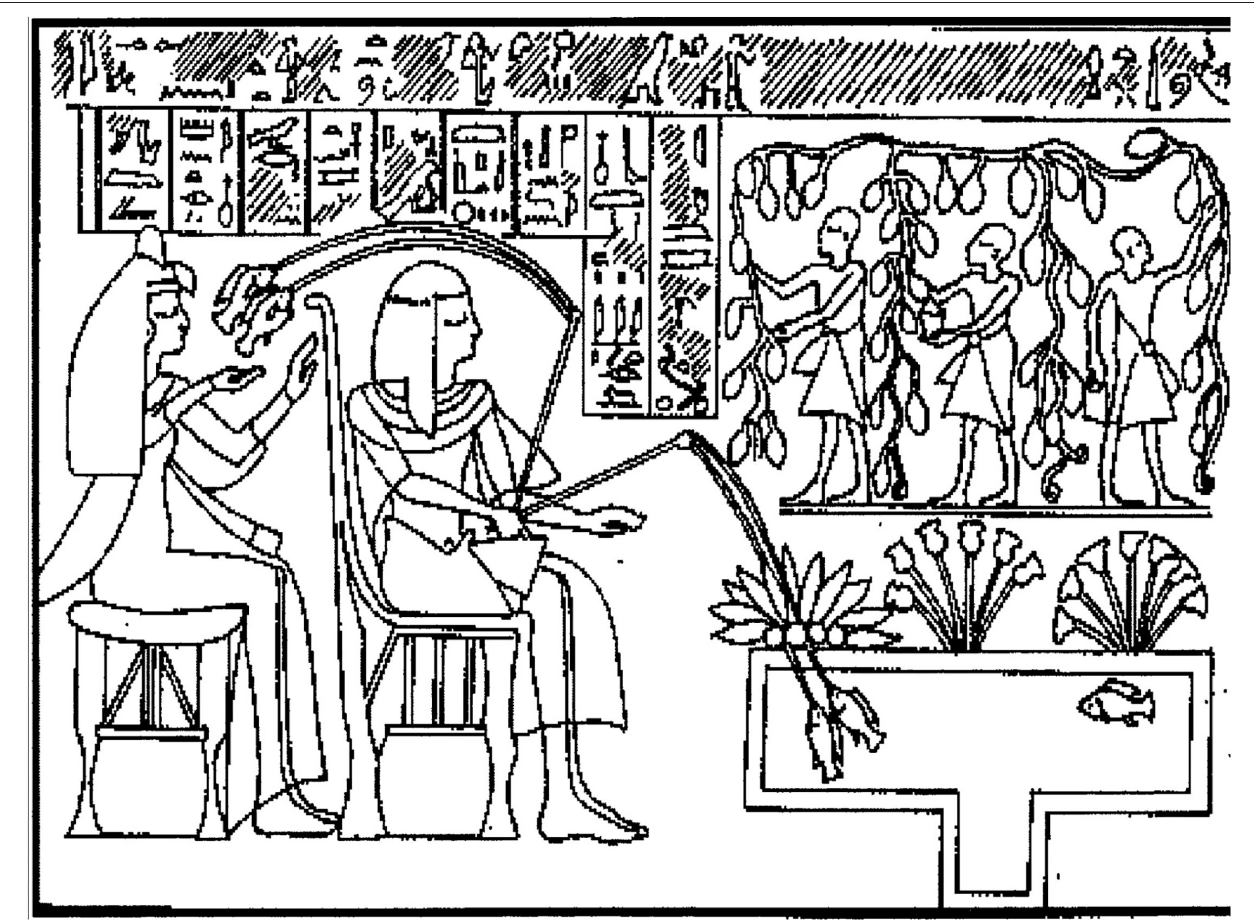
FIGURE 1 | Bas relief on the Tomb of Thebaine, Nile Delta, Egypt circa 2000 B.C. Note the central drainage canal, floating lotus plants, and juxtaposition of tank to fruit trees. These components are used in modern aquaculture to harvest fish, provide shade, water quality control by aquaponics plants, and shelter for fish,